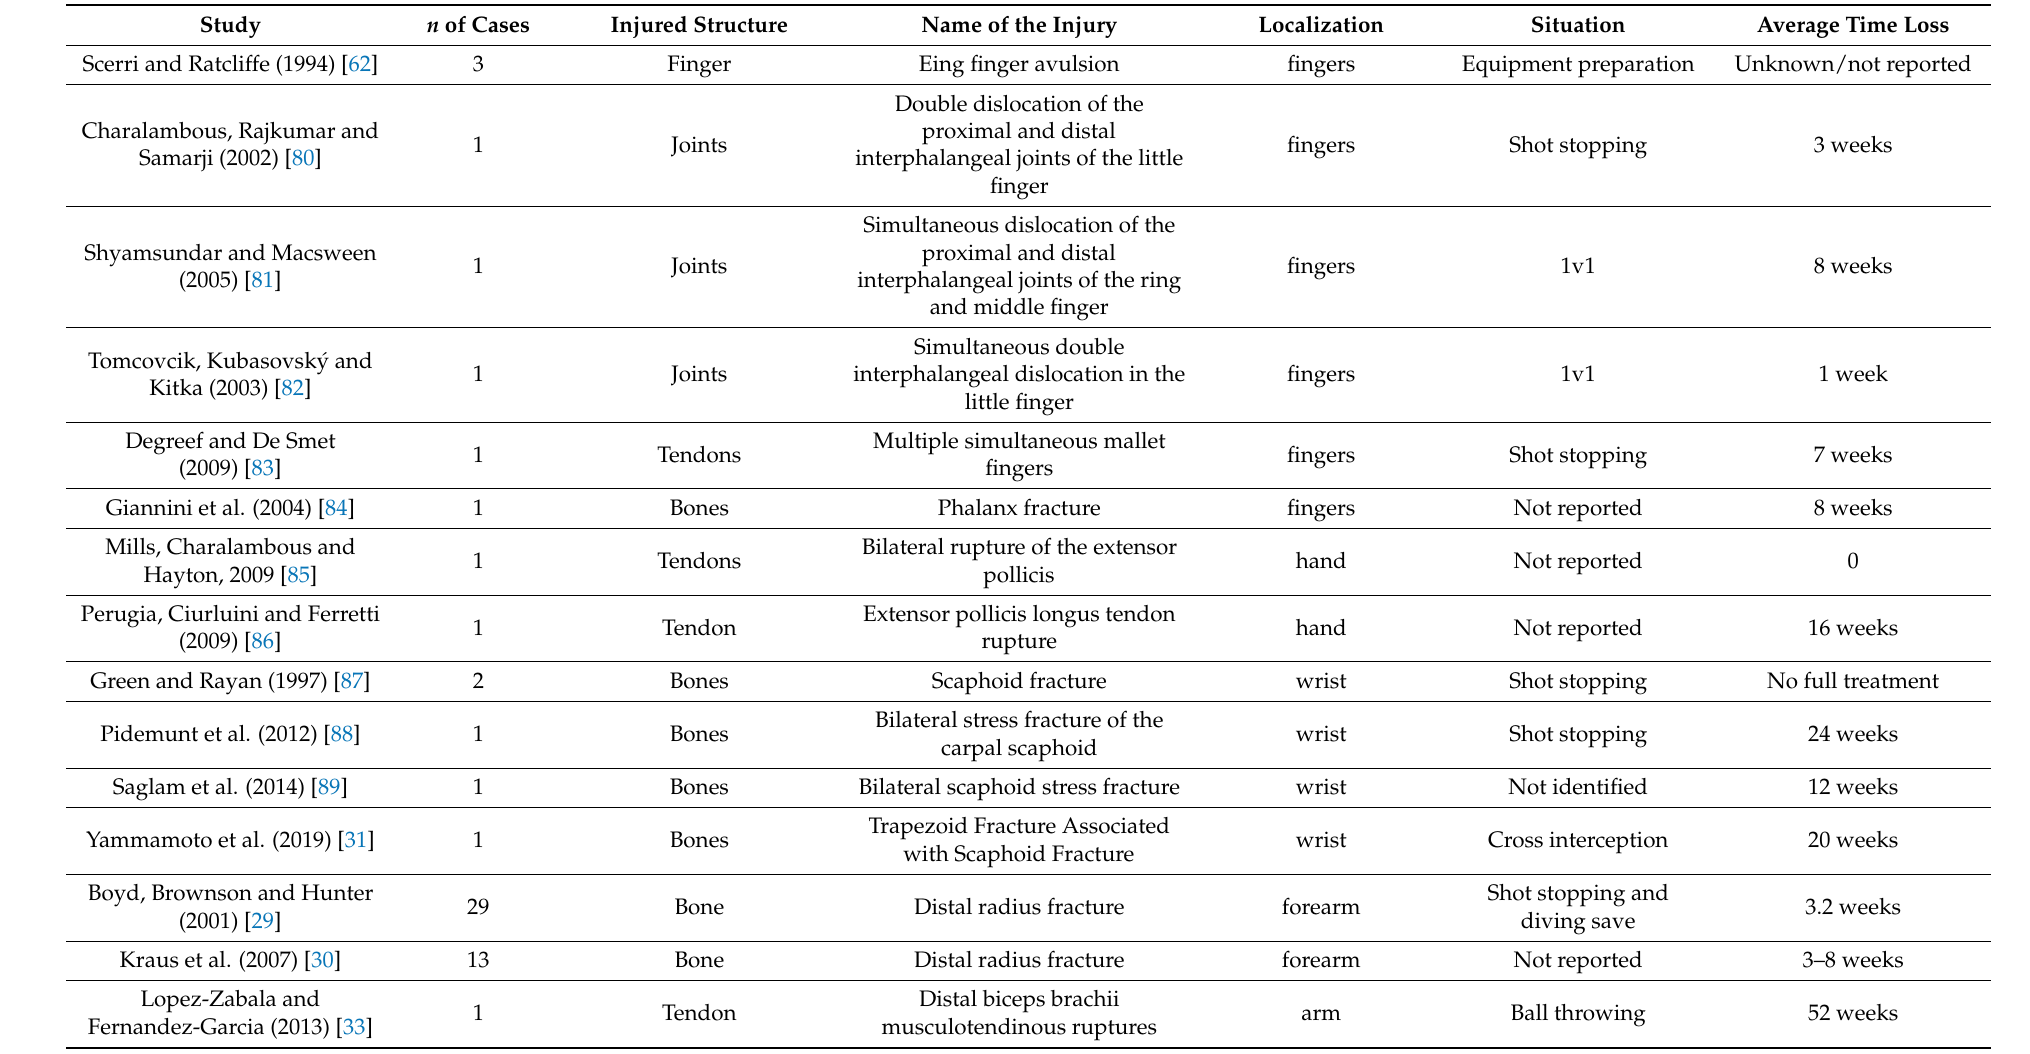
Table 4. Summary of the case studies outlining goalkeeper